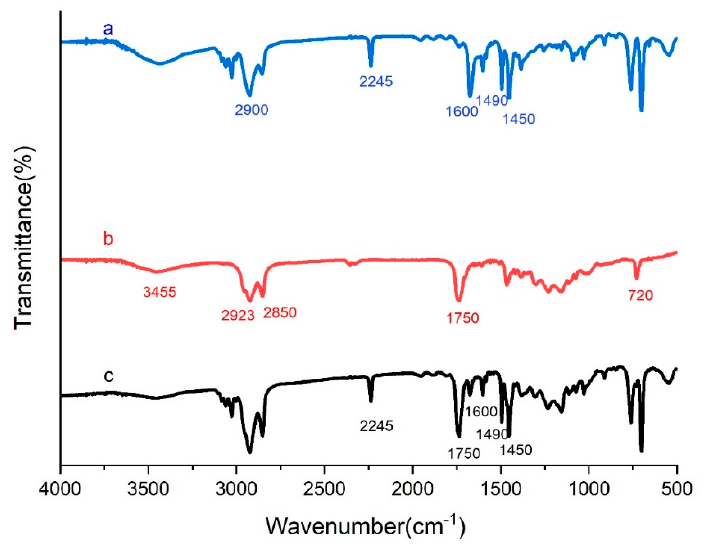
Figure 3. FTIR spectra of ( a ) neat SAN nanocapsules; ( b ) neat CAR; ( c ) and crushed nanocapsules obtained from coaxial electrospraying.